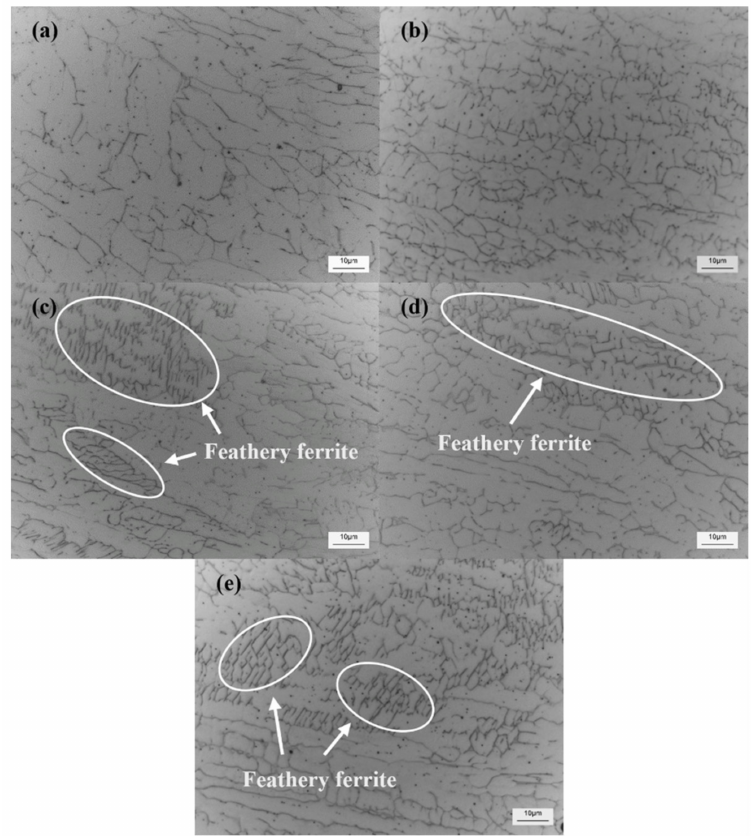
Figure 11. Microstructural images obtained from the optical microscope for the WMs. ( a – e ) 0 A, 10 A, 20 A, 30 A, and 40 A currents,